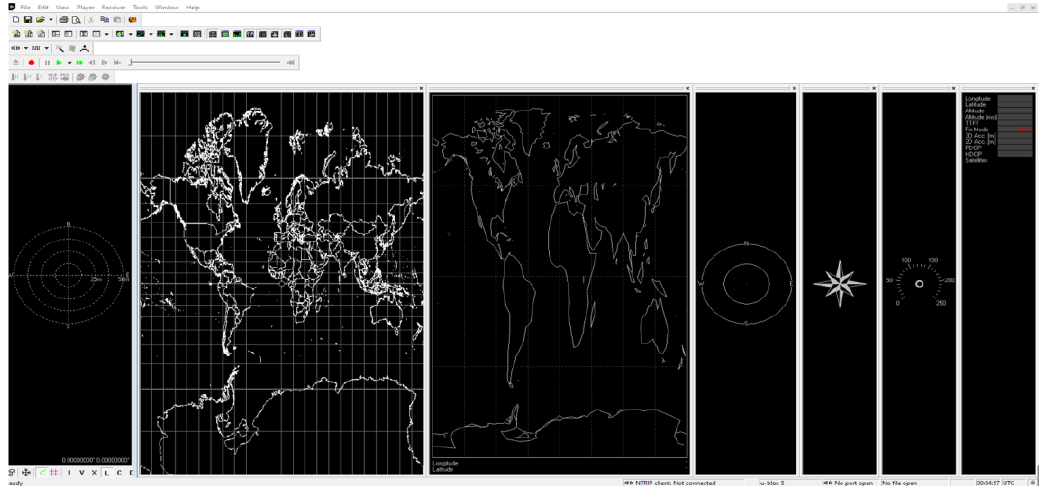
Figure 2. U-centre software